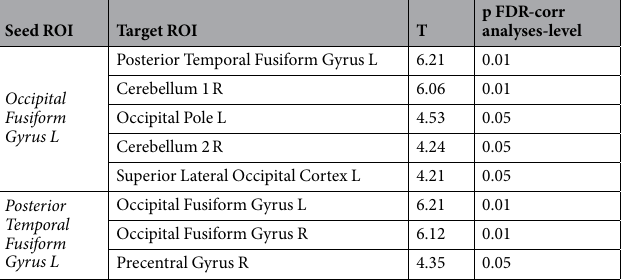
Table 4. Within-patients: connections with greater seed-to-target connectivity in the sated compared with the fasted state.